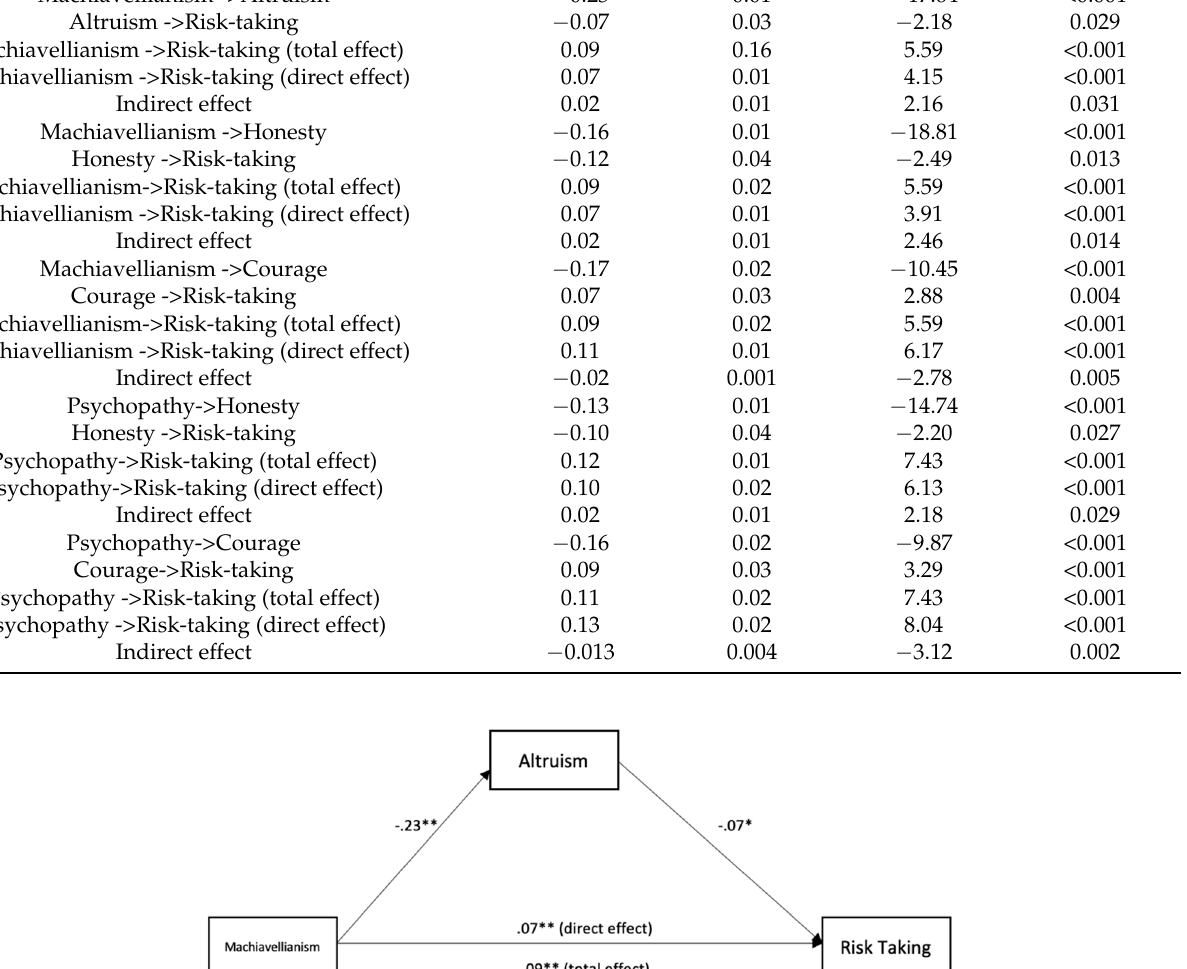
Figure 2. Mediation analysis for the relationship between Machiavellianism, honesty, and risk- taking . ** p < 0.01.